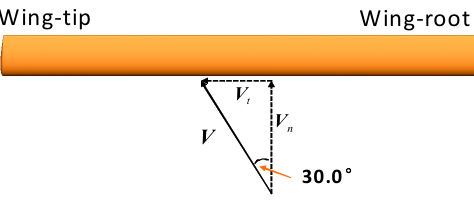
Figure 9. Schematic of a finite wing with spanwise flow.